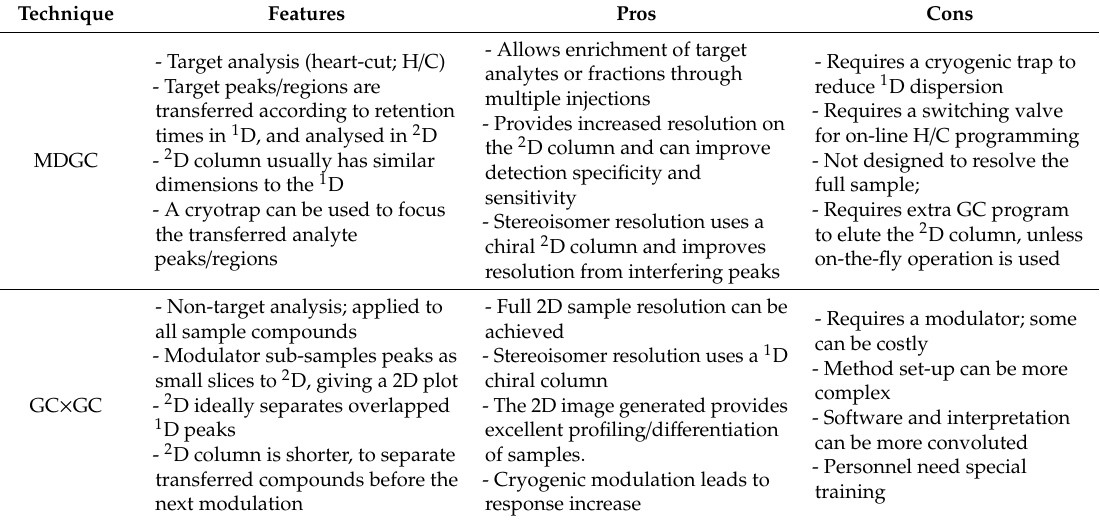
Table 1. Multidimensional (MDGC) and comprehensive two-dimensional gas chromatography (GC × GC) general features and